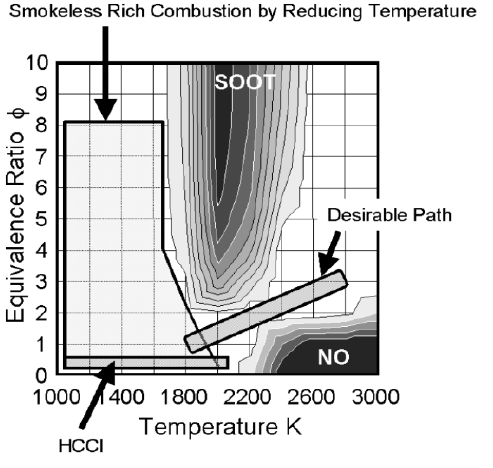
Figure 1. Comparison between new combustion concepts on a Φ -T map